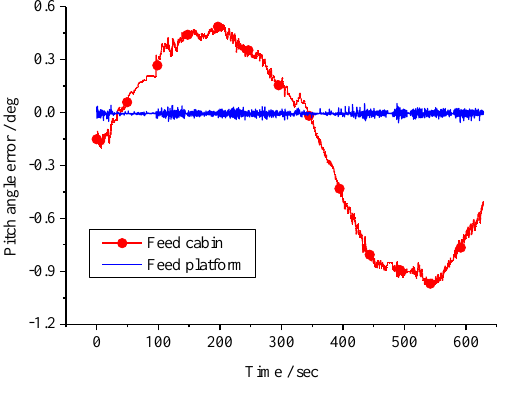
Figure 16. Pitch angle Figure 16 . Pitch angle error.